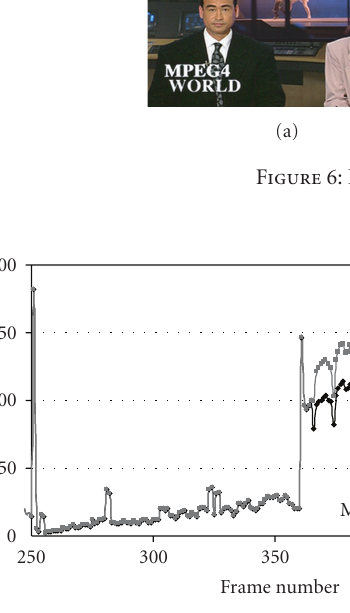
Figure 7: Improvement of the modified dissimilarity metric behaviour in the case of high-motion video sequences.